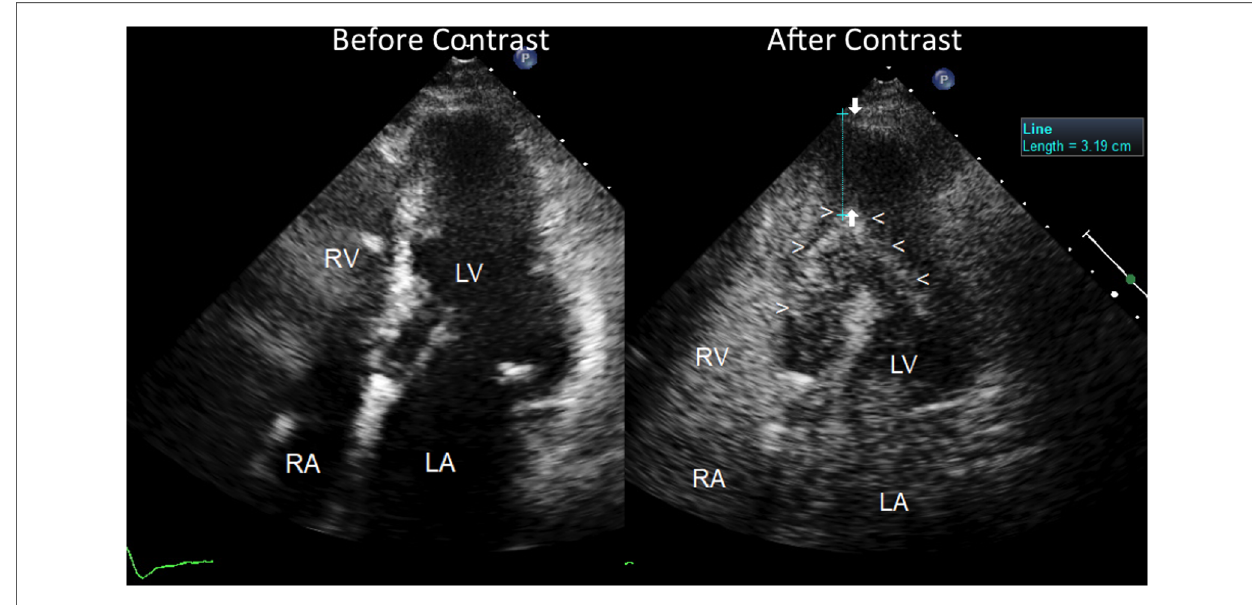
FIGURE 3 Severe apical left ventricular hypertrophy, as assessed by contrast enhanced transthoracic echocardiography. Four chamber view before (on the left) and after ultrasound contrast injection (on the right). Before contrast, the LV apical region does not show any clear delineation of the endocardial border but reveals a fairly homogeneous low backscatter echo-structure resembling a blood pool. No evident abnormality of the LV apical region can be noted but just poor quality imaging of the apical region with scarce delineation of the endocardium; the pace-maker leads can be noted in the right atrial cavity. On the contrary, after contrast injection (Sonoview ® 1 cc in bolus) (on the right), a perfect delineation of the true apical endocardium is very clearly depicted as a hyper re fl ective line of backscatter (arrowheads). The severe hypertrophy of the LV apical wall can be noted and measured, as indicated by arrows (>3 cm thickness). The left atrium is dilated. The right atrial cavities are fi lled with contrast medium. LV=left ventricle; RV=right ventricle; RA=right atrium; LA=left